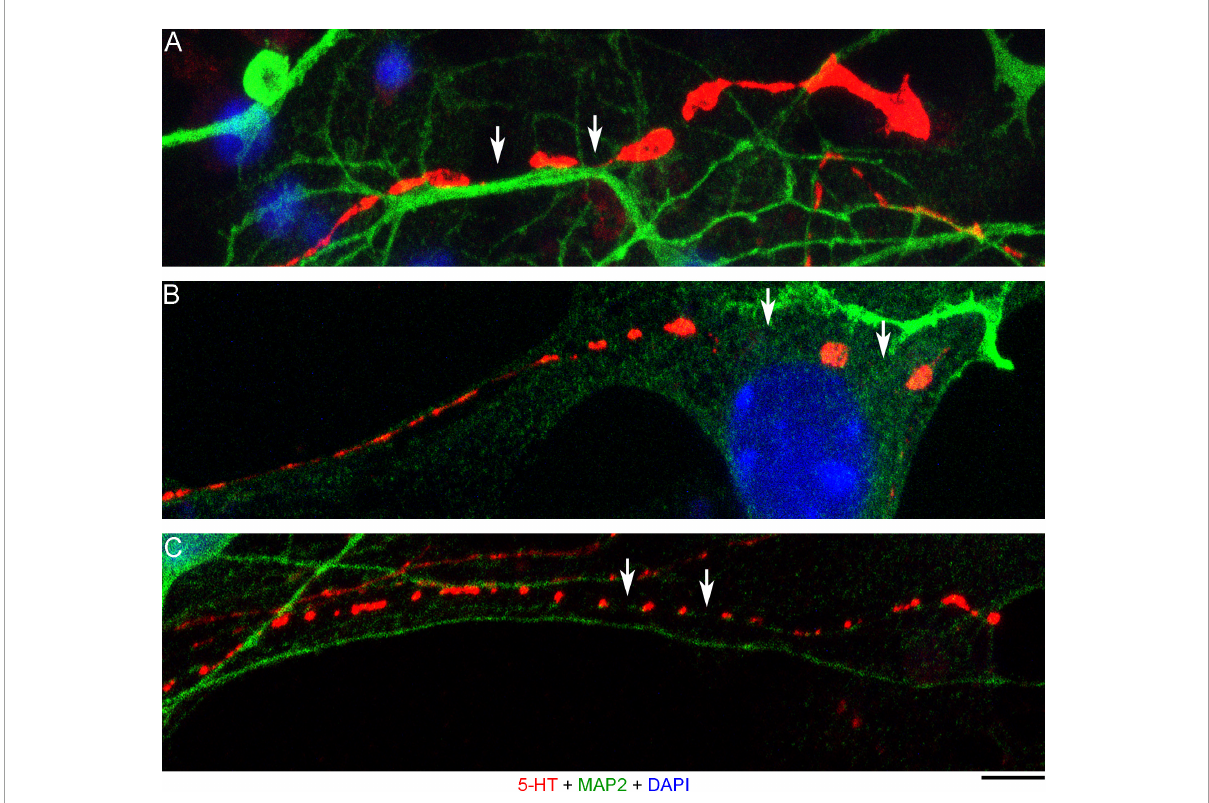
FIGURE4 Primary midbrain cultures (all monolayers at DIV 4), visualized with immunocytochemistry for 5-HT (red) and MAP2 (green) and imaged with high-resolution confocal microscopy. (A) The growth-cone region of a serotonergic axon (5-HT + /MAP2–) that shows wide gaps in 5-HT-immunoreactivity (arrows). These gaps may be due to nanoscale-caliber bridges between intensely labeled segments or actual interruptions in fiber continuity. The presence of normal-caliber segments virtually devoid of 5-HT also cannot be ruled out. (B) A serotonergic axon or a series of its adhesion sites (5-HT + /MAP2–) that transitions from a thin, nearly continuous trace to a much thicker trace with large gaps (arrows) between circular 5-HT + regions. (C) A serotonergic axon or a series of its adhesion sites (5-HT + /MAP2–) that shows circular 5-HT + regions (around 1 µ m in diameter) spaced at around 4 µ m (arrows). Scale bar (shared by all panels) = 5 µ